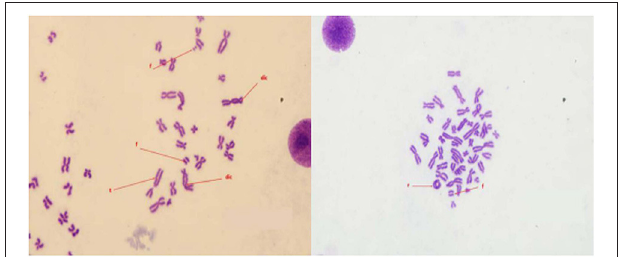
FIGURE 1 | Image of chromosome aberration (Fragment [F], Translocation [T], Dicentric [dic], Centric ring [r]).